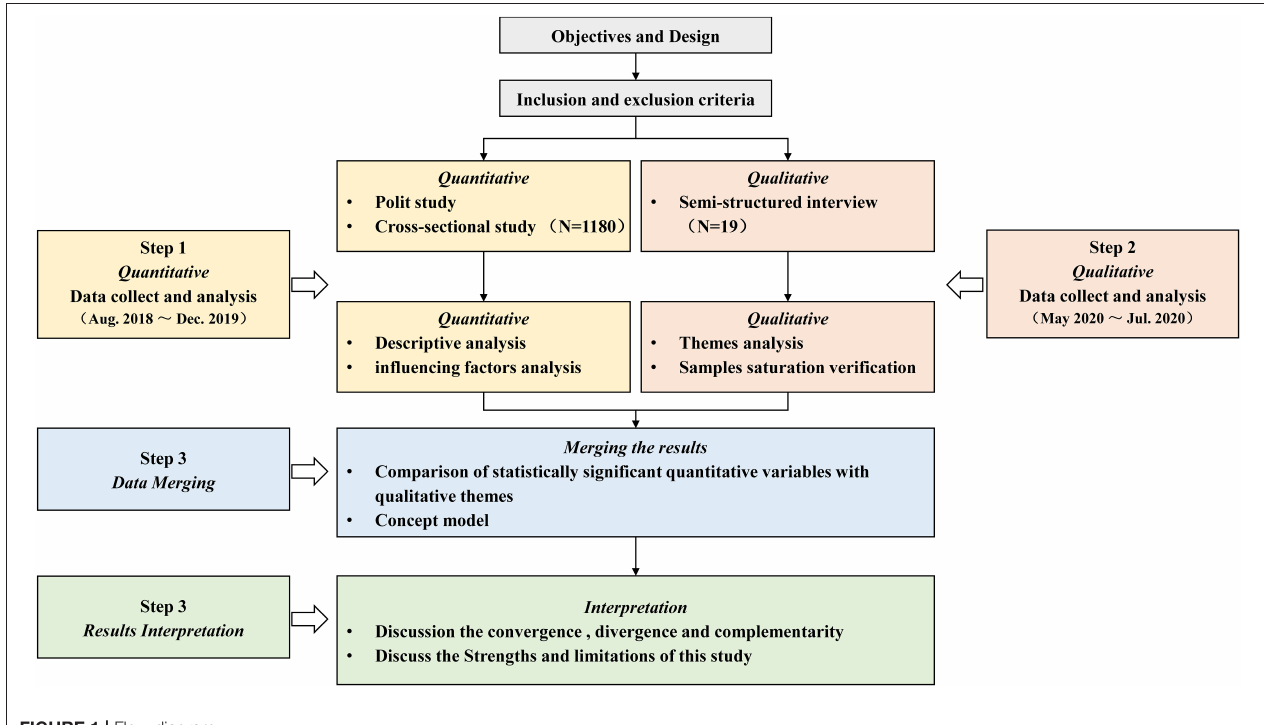
FIGURE 1 | Flow diagram.